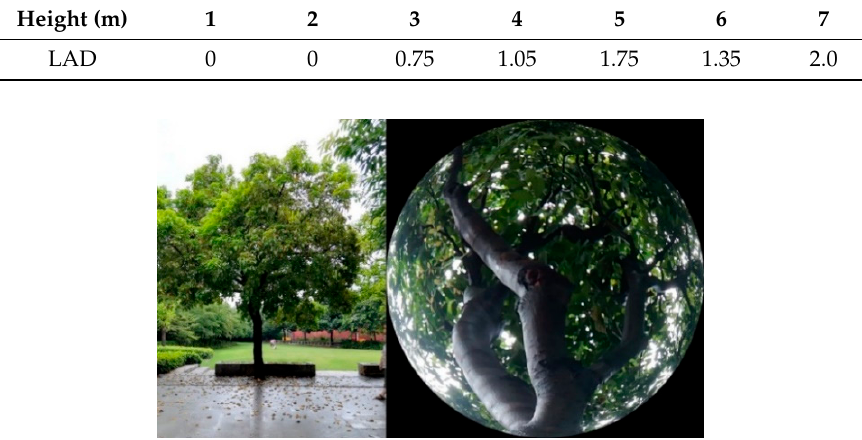
Figure 9. Vertical configuration of the tree (Bischofia javanica).